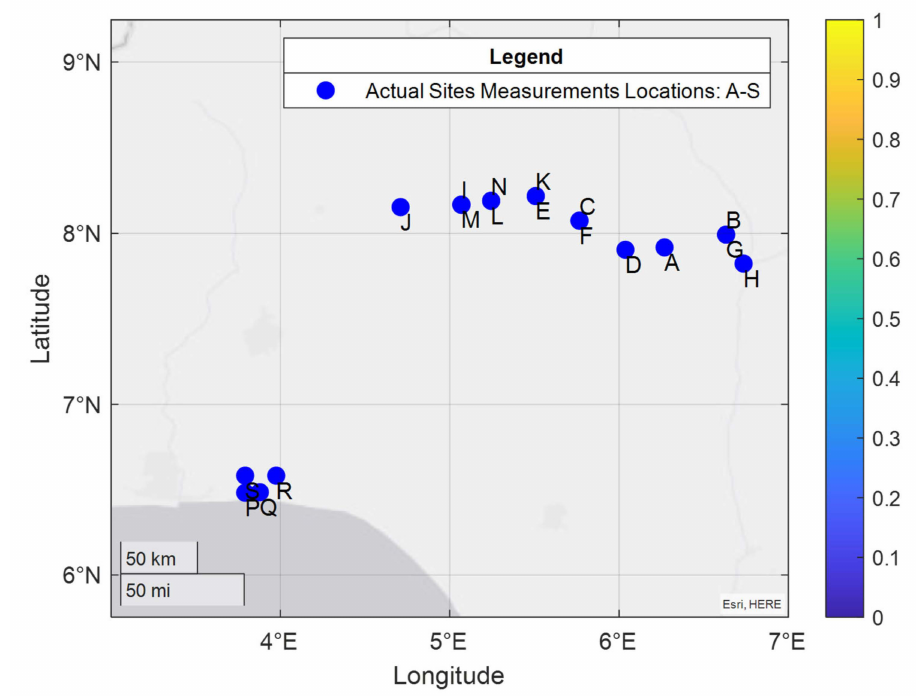
Figure 2. The geographical coordinates of the measurement